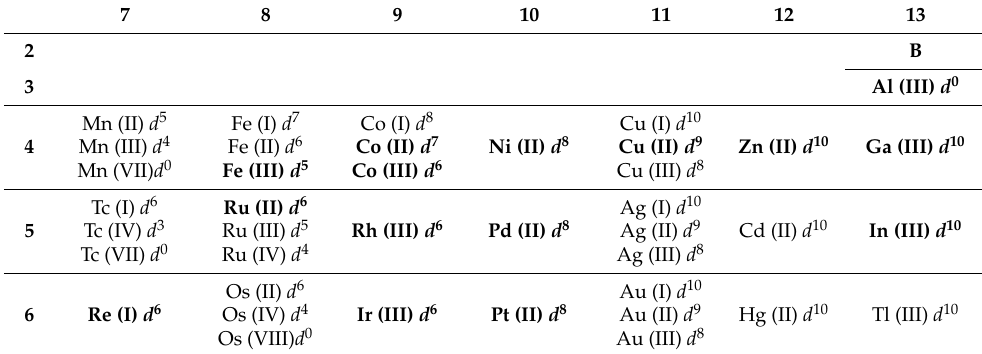
Table A7. Occupancy of d orbitals for organometallic complexes ( d electron count) of various metal ions [181] in Group 7 to 13 and Period 3 to 6 of the Period Table that feature in this treatise (in bold), and some others